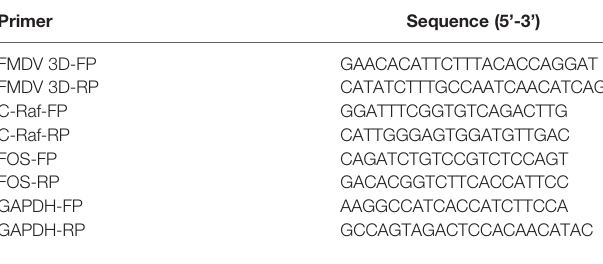
TABLE 1 | Primers sequences used in this research.